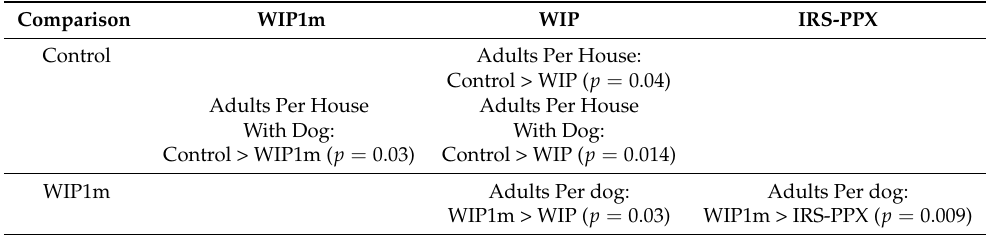
Table 3. Statistically significant comparisons (Tukey